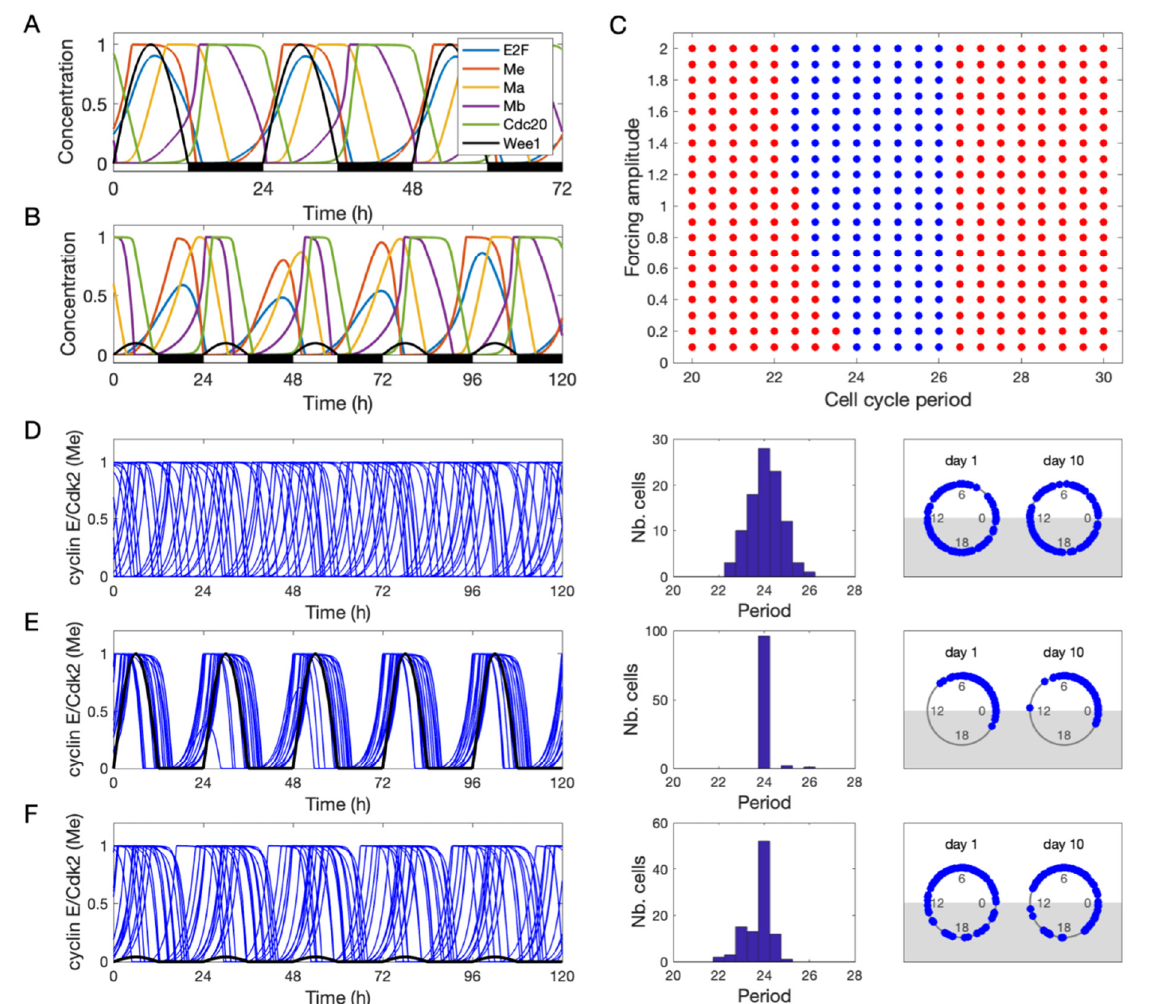
Figure 3. Entrainment of the cell cycle by the circadian clock. ( A ) Entrainment of the cell cycle to 24 h period when the autonomous period of the cell cycle was very close to 24 h (µ = 0.3718) and when the amplitude of the circadian input was sufficiently high ( A = 1). ( B ) Lack of entrainment of the cell cycle when the autonomous period was set to 29.75h (µ = 0.3) and when the amplitude of the circadian input was low ( A = 0.1). ( C ) Entrainment (blue dots) vs. non-entrainment (red dots) as a function of the autonomous cell cycle period and of the circadian amplitude. Entrainment was achieved if oscillations were phase locked and had a constant amplitude. ( D ) Time evolution of a population of cells with a variability of 10% applied on all parameters. More specifically, the value of each parameter was changed by a value of x % with x randomly selected in the range [−10, 10]. The dynamics of Me is shown for 15 cells taken from a population of 100 cells. ( E ) Circadian entrainment of the same population of cells ( A = 1). ( F ) Partial entrainment of the same population of cells at a low circadian amplitude ( A = 0.1). The black curves in panels ( E , F ) denote the profile of Wee1 activity. On the right of each time series are the distributions of the periods and of the phases on day 1 and day 10. Phase 0 corresponds to the dark–light transition and the phase of each oscillator was determined by the time of day at which the maximum of variable Me was reached.